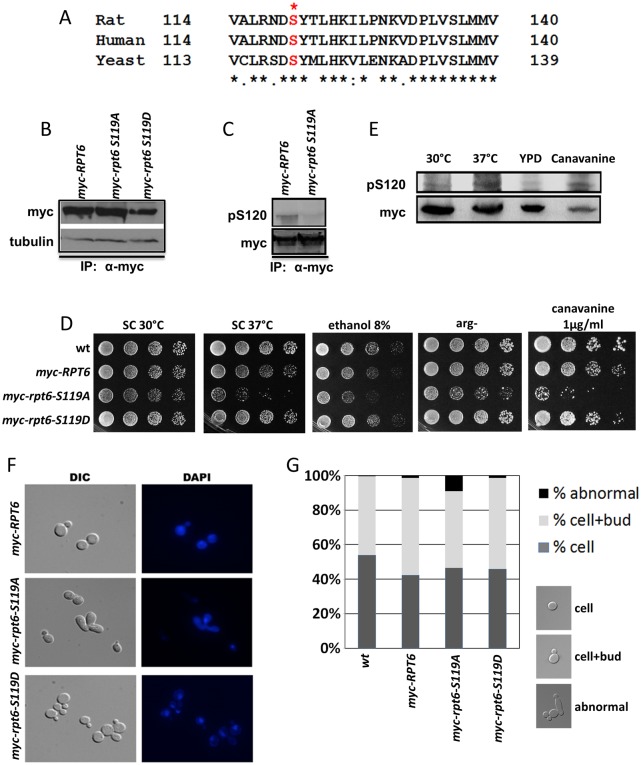
The rpt6-S119A mutants had increased susceptibility to proteotoxic stress and displayed abnormal morphology. (A) Alignment of Rpt6 sequences from rat, human and yeast indicate conservation of the S120 phosphorylation site. Note the presence of a serine at position 117 in yeast. This residue may contribute to some cross-immunoreactivity for the pS120 antibody in the myc-rpt6-S119A strain (see below). (B) Qualitative analysis of myc-tagged Rpt6 (myc-Rpt6) expression. Immunoblot depicts similar levels of expression in strains tested. (C) Representative immunoblot of myc-RPT6 and myc-rpt6-S119A lysates immunoprecipitated with α-myc antibodies and resolved on SDS-PAGE. The anti-Rpt6 pS120 antibody recognizes wild-type myc-Rpt6, whereas little to no signal is observed for the myc-rpt6-S119A mutant, suggesting that Rpt6 is phosphorylated in yeast. (D) Increased sensitivity to proteotoxic stress is observed in the myc-rpt6-S119A mutant. The fitness of the myc-rpt6-S119D strain was comparable to myc-RPT6. The myc-rpt6-S119A strain was sensitive to elevated temperature, ethanol and canavanine. Arg- medium serves as a control for canavanine, which is a toxic analog of arginine. (E) Phosphorylation of endogenous Rpt6 is increased upon stress. Protein lysates from cells grown under normal and stress conditions (37° and canavanine (1ug/ml;2h)) were probed with the anti-pS120 antibody. (F) Representative micrographs of myc-RPT6 strains (DIC and DAPI) during log phase indicate abnormal morphology in the myc-rpt6-S119A mutant. (G) Quantitative analysis of morphological studies in (F). Graphs denote 3 independent experiments. Abnormal morphology is increased to 10% of the total population in myc-rpt6-S119A.